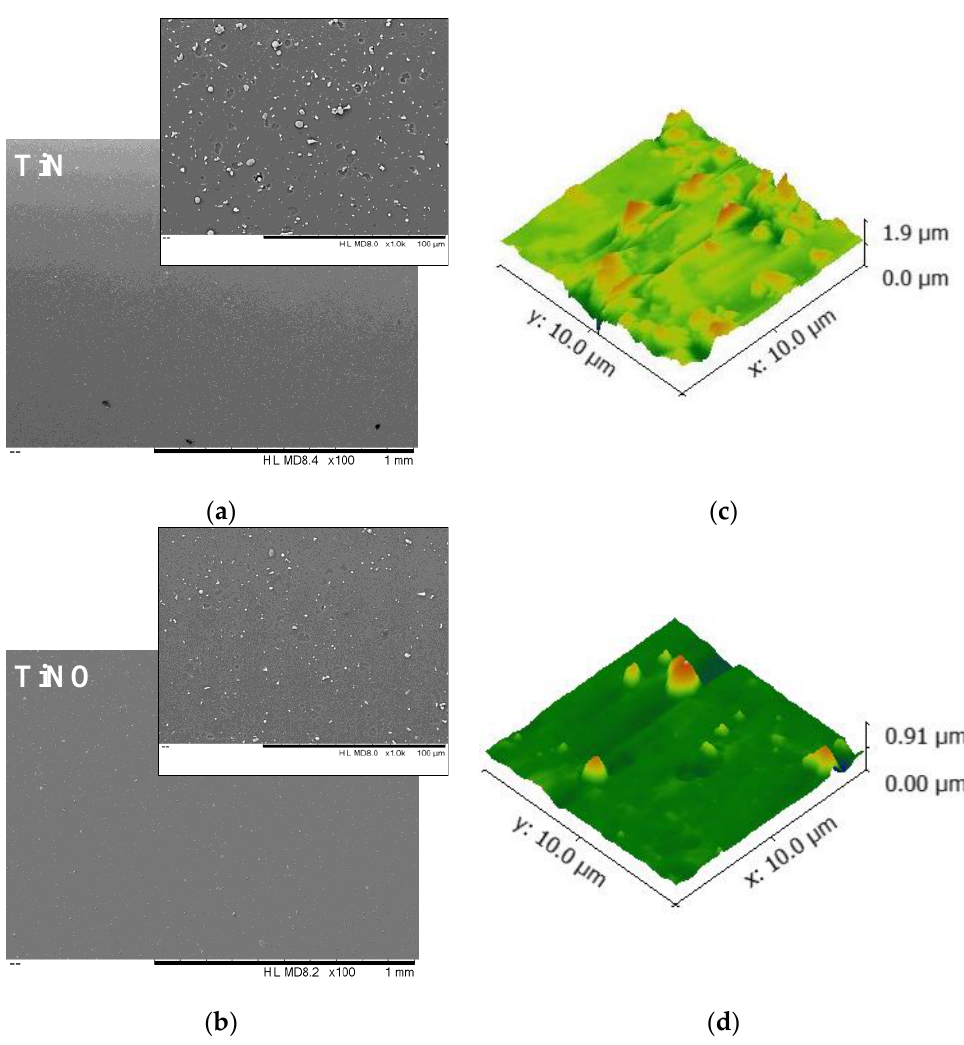
Figure 3. Surface morphology. ( a ) SEM image of TiN coating; ( b ) SEM image of TiNO coating; ( c ) AFM image of TiN coating; ( d ) AFM image of TiNO coating.